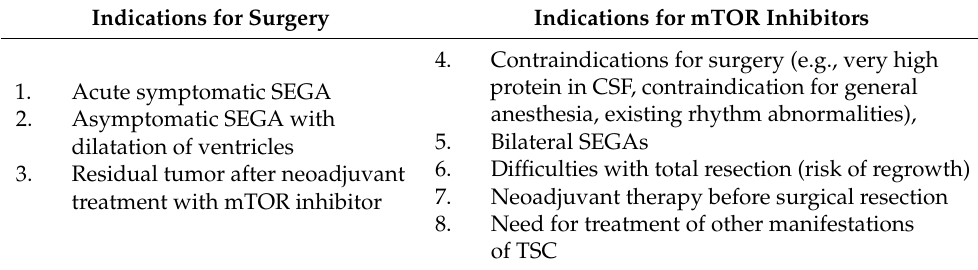
Table 2. Indications for surgical and medical treatment of